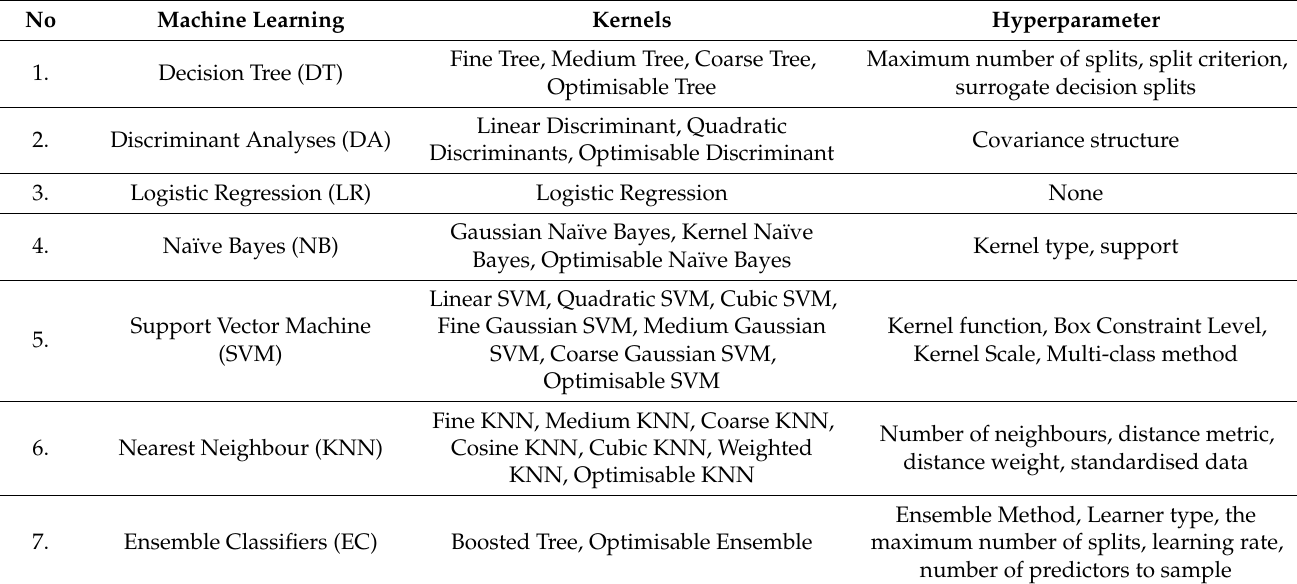
Table 3. The list of ML classifiers, kernel and hyperparameter options used in the